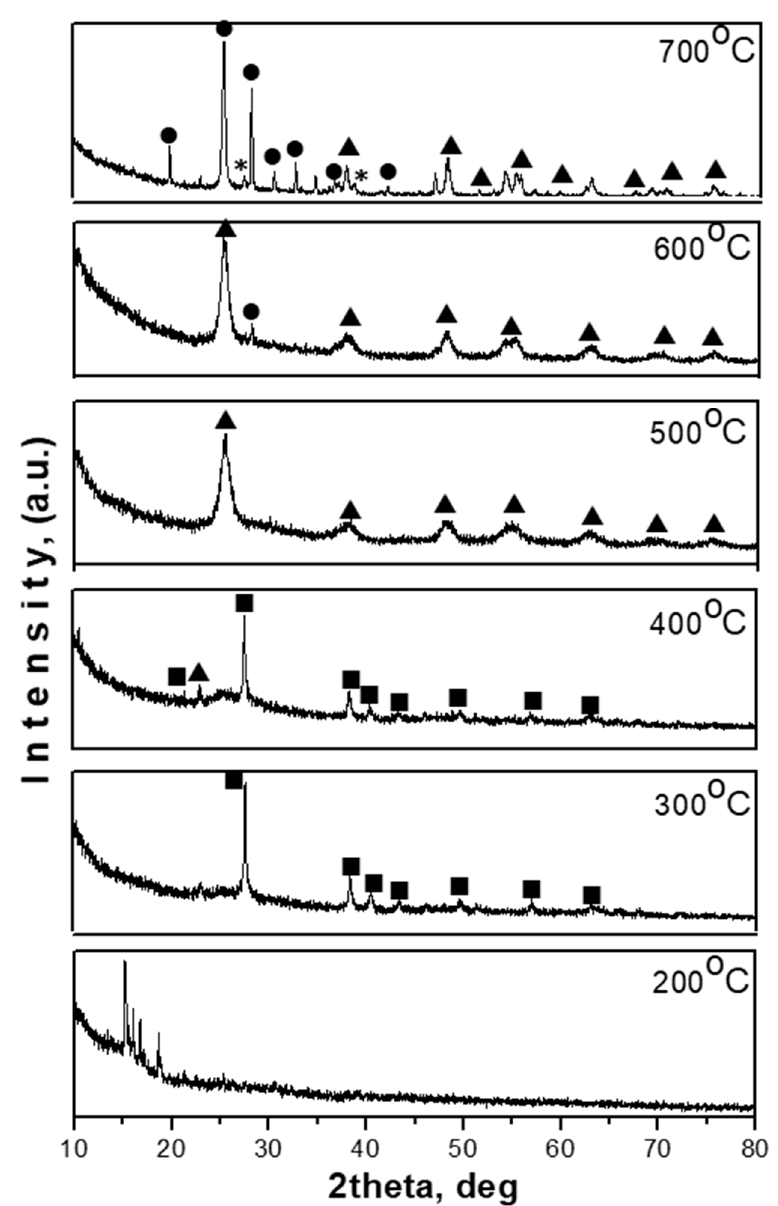
Figure 1. XRD patterns of sample with nominal composition 90TiO 2 .10TeO 2 heat treated at different temperatures: ( (cid:4) ) Te, ( (cid:78) ) TiO 2 -anatase, (